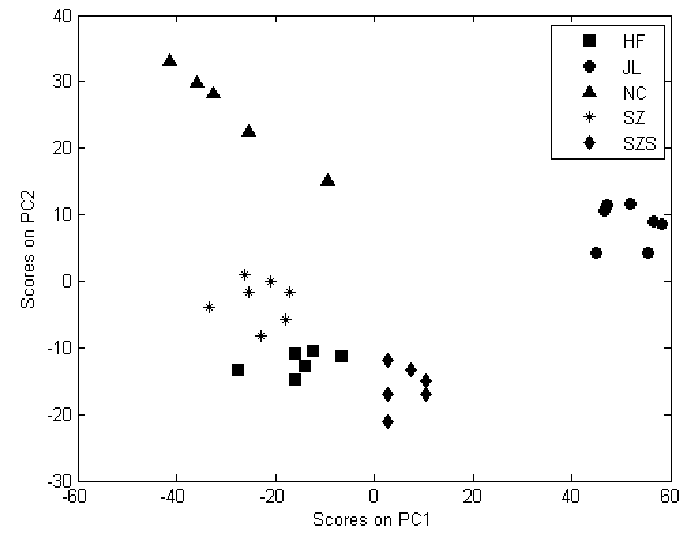
Figure 5. Score scatter plot for the first two PCs of rice grain sample.